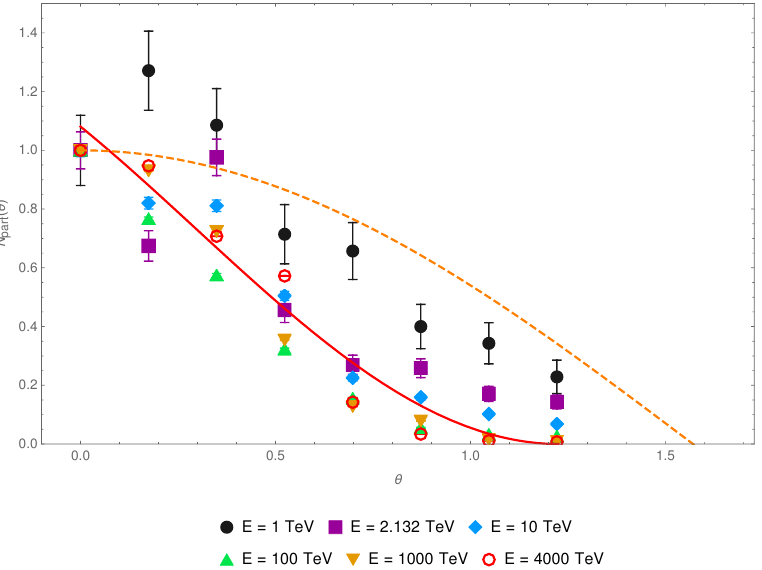
Figure 5. Normalised relation N part ( θ ) / N part ( 0 ) with fitted scaling factor F θ ( θ ) (red solid line) for electrons in cascades initiated by protons. It shows how the number of secondary particles which reach the ground changes with an increasing angle of incidence of primary cosmic-ray particles. The dashed line represents the cos ( θ ) function. For clarity of the picture, only selected energies are